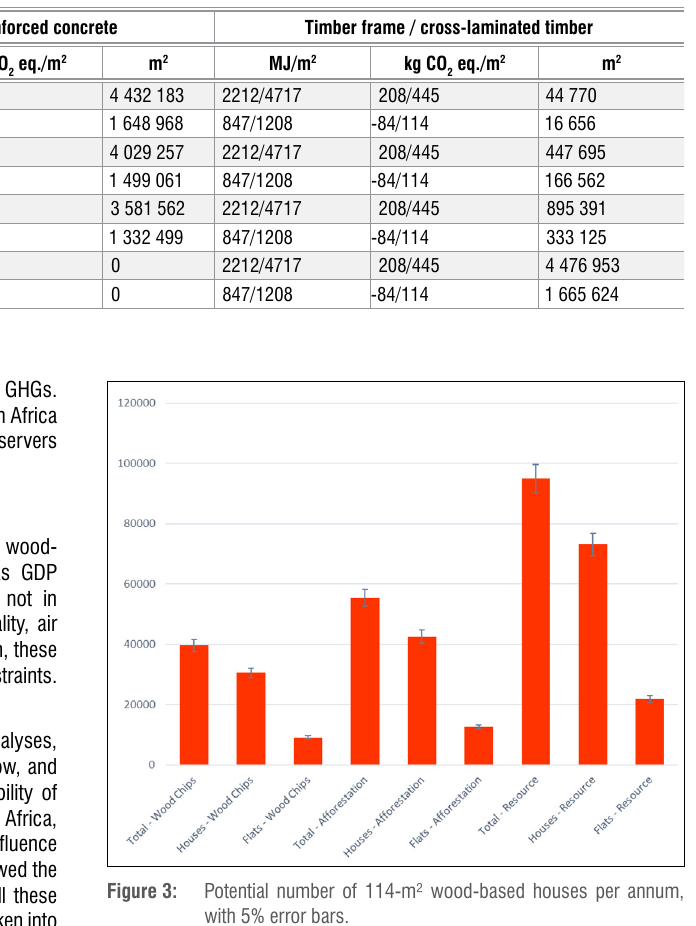
Four projected development scenarios with minimum and maximum impact